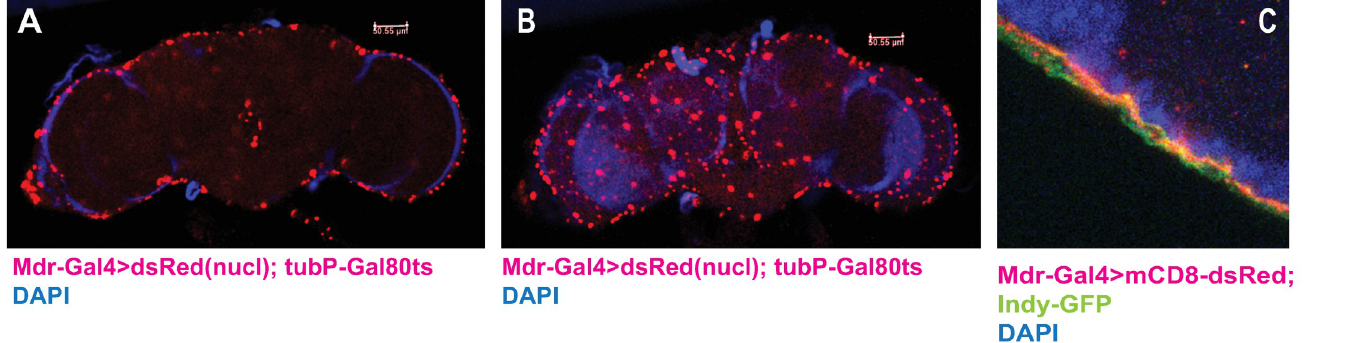
Fig 2. Mdr-Gal4 driver is expressed in SPG nuclei. (A, B) Visualization of our newly constructed Mdr-Gal4 driver with a nuclear dsRed reporter reveals expression in SPG nuclei. The nuclei differ in size because of different polyploidy grades [24]. Mdr-Gal4/UAS-dsRed; tubP-GAL80ts males were induced using the same protocol used in courtship assays. 20x magnification, size bar = 50um. (C) Mdr-Gal4 > UAS-dsRed expression (red) coincides with expression of Indy-GFP in the SPG, but not the outer PG layer. Indy-GFP is a marker for both PG and SPG cells.